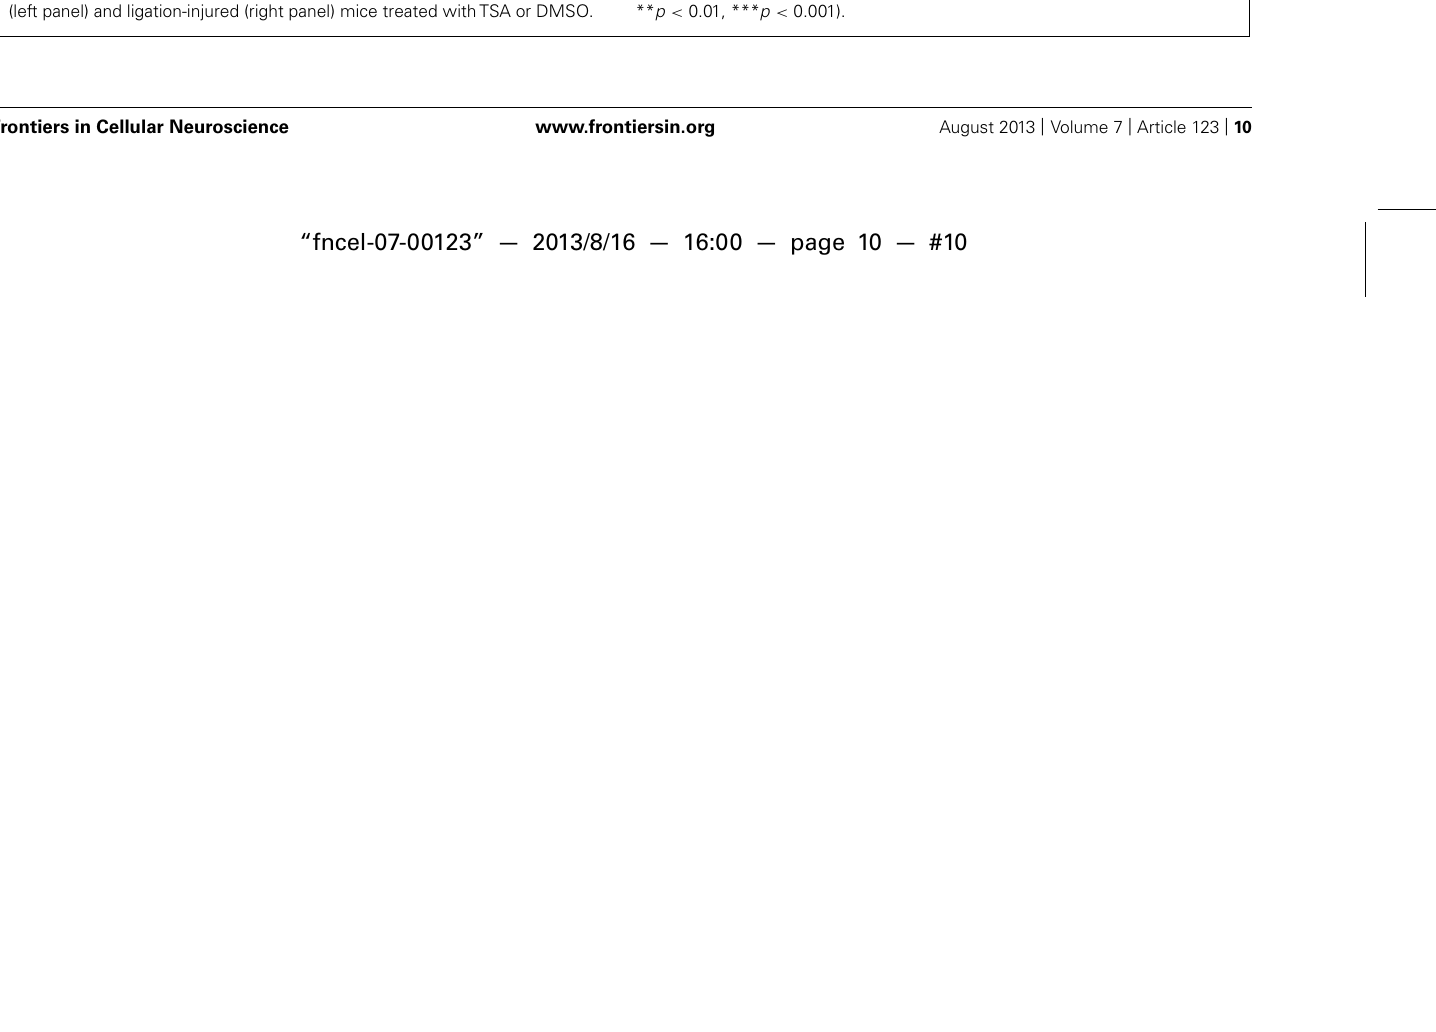
(C) Average densities of BrdU + /NeuN + cells along the subgranular zone (SGZ) in both ligation-uninjured (left panel) and ligation-injured (right panel) mice treated withTSA or DMSO. (D) Percent of BrdU-positive cells along the SGZ that express NeuN in both ligation-uninjured (left panel) and ligation-injured (right panel) mice treated withTSA or DMSO (* p < 0.05, ** p < 0.01, *** p <